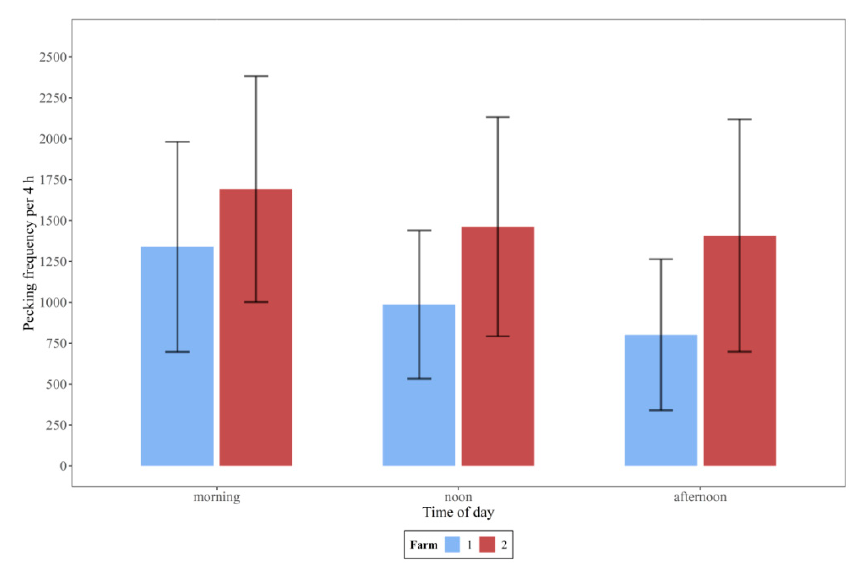
Figure 2. Mean pecking frequencies (and standard deviation) in the morning, at noon and in the afternoon (each over 4 h, n = 28 days) on farm 1 and 2.